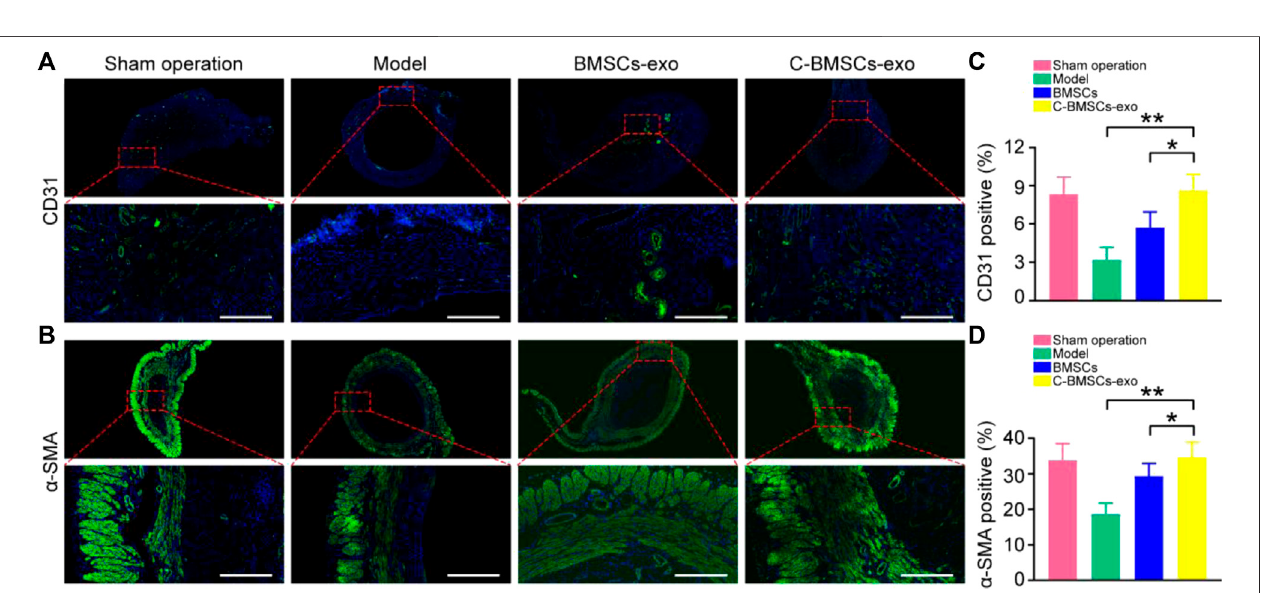
Frontiers in Bioengineering and Biotechnology |